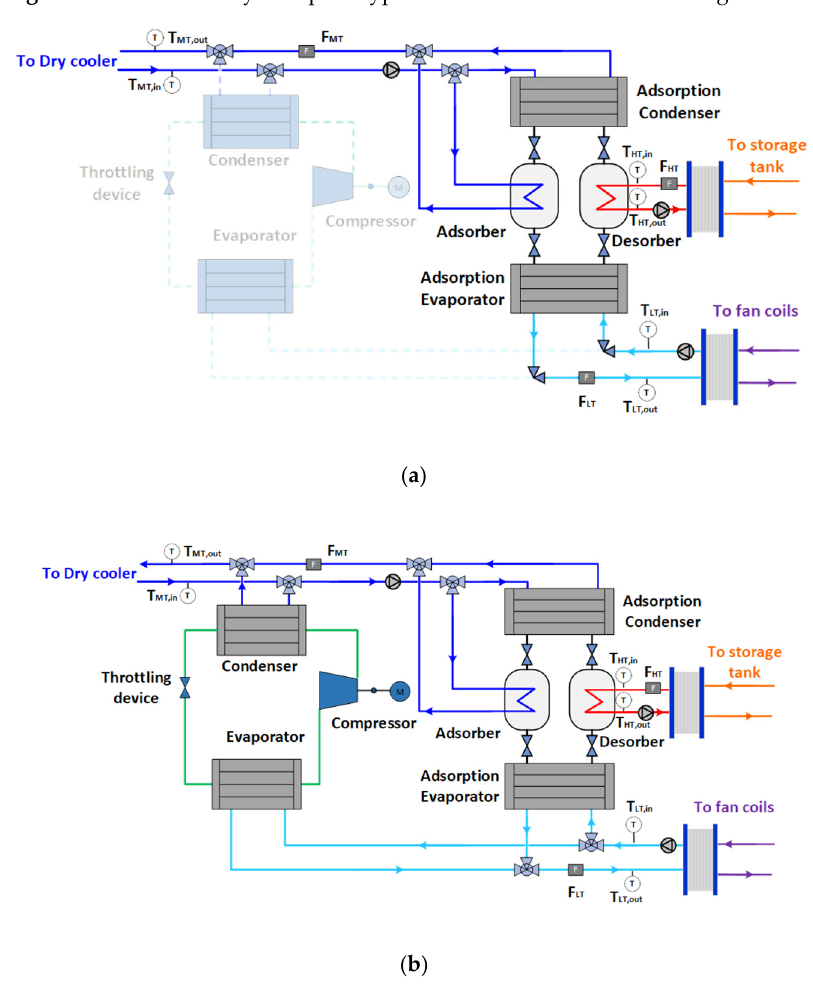
Figure 2. Detailed schematic of the hybrid adsorption chiller/backup heat pump module: ( a ) in adsorption only mode; ( b ) in combined operation.